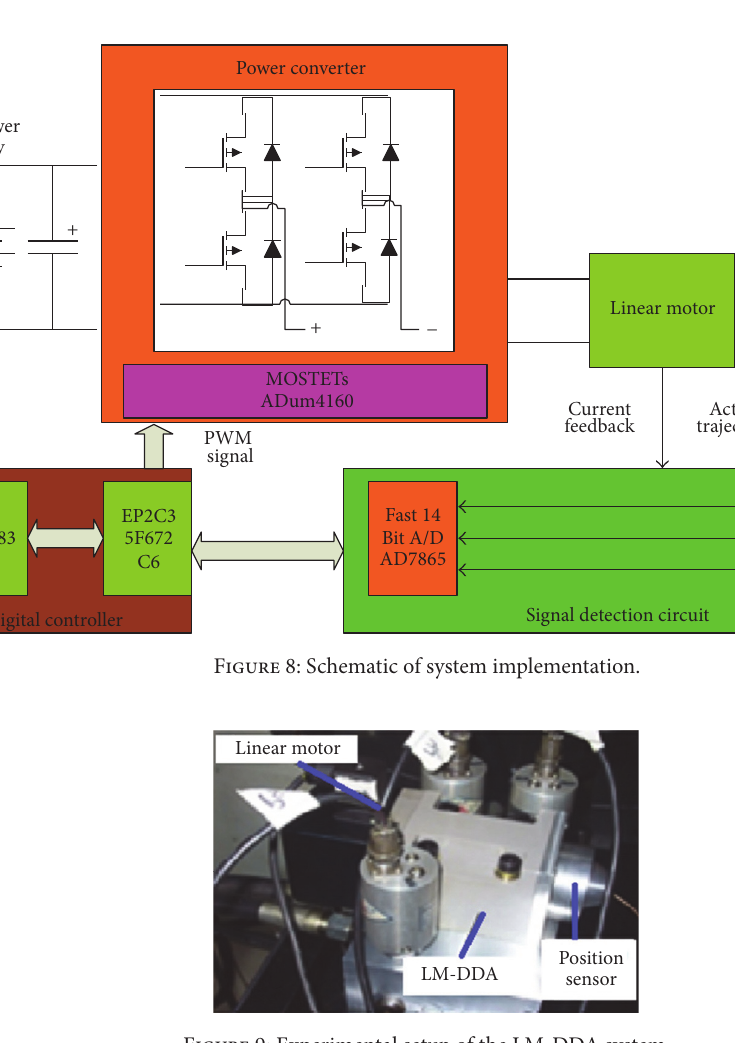
Figure 9: Experimental setup of the LM-DDA